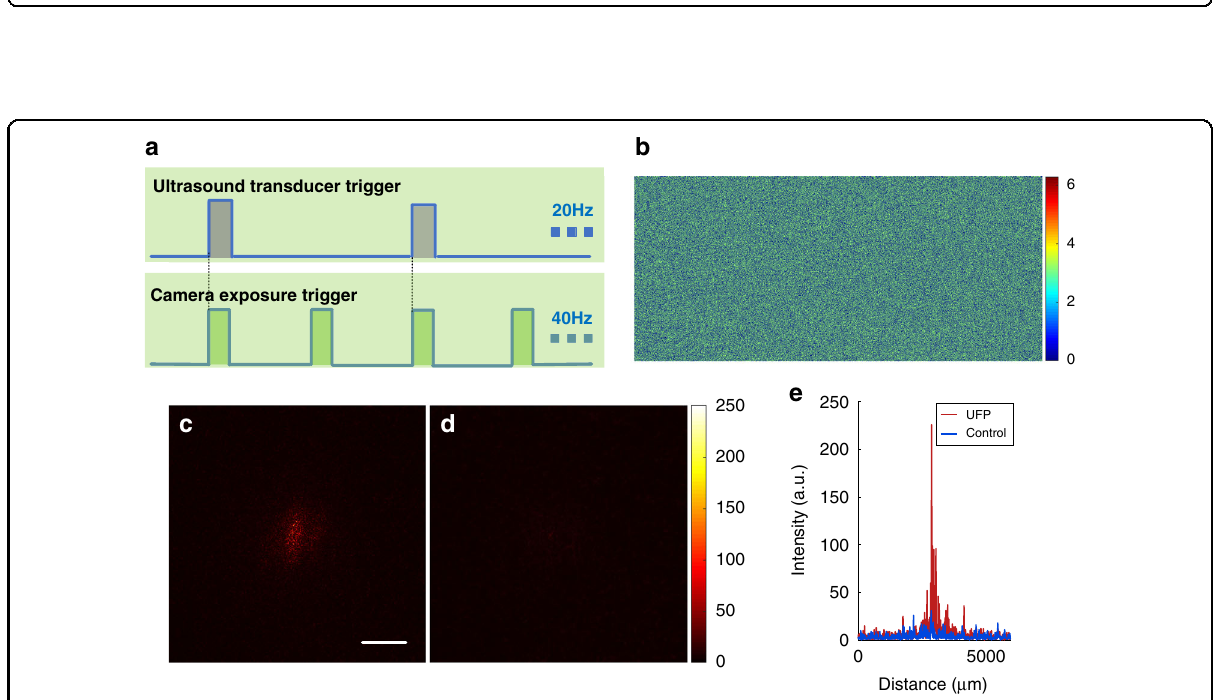
Fig. 4 UFP optical focusing into scattering media via a full-phase modulation scheme. a Phase map displayed on the SLM, based on the differential signal between the measured complex fi elds when the ultrasound was OFF and ON. b Time-reversed focus from UFP optical focusing. c No optical focus was observed in a control experiment conducted without launching the ultrasound. d Time-reversed focus from conventional TRUE optical focusing under the same condition. e Line pro fi les of the central rows in b – d . Scale bars: 1 mm